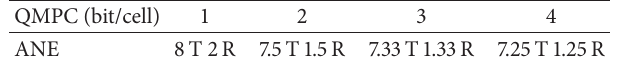
Table 6: Corner analysis of 𝑉 during second recall. d2 NMOS Slow Typical